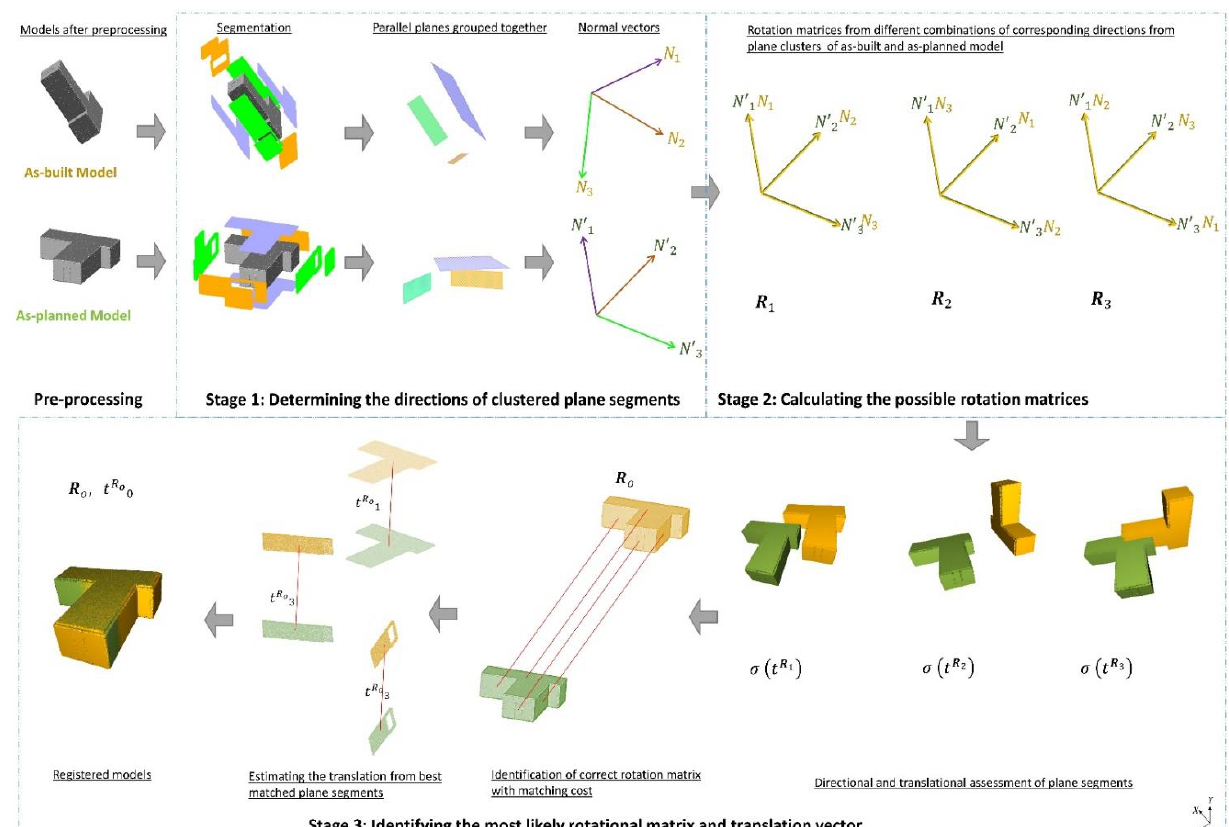
Figure 1. Overall methodology